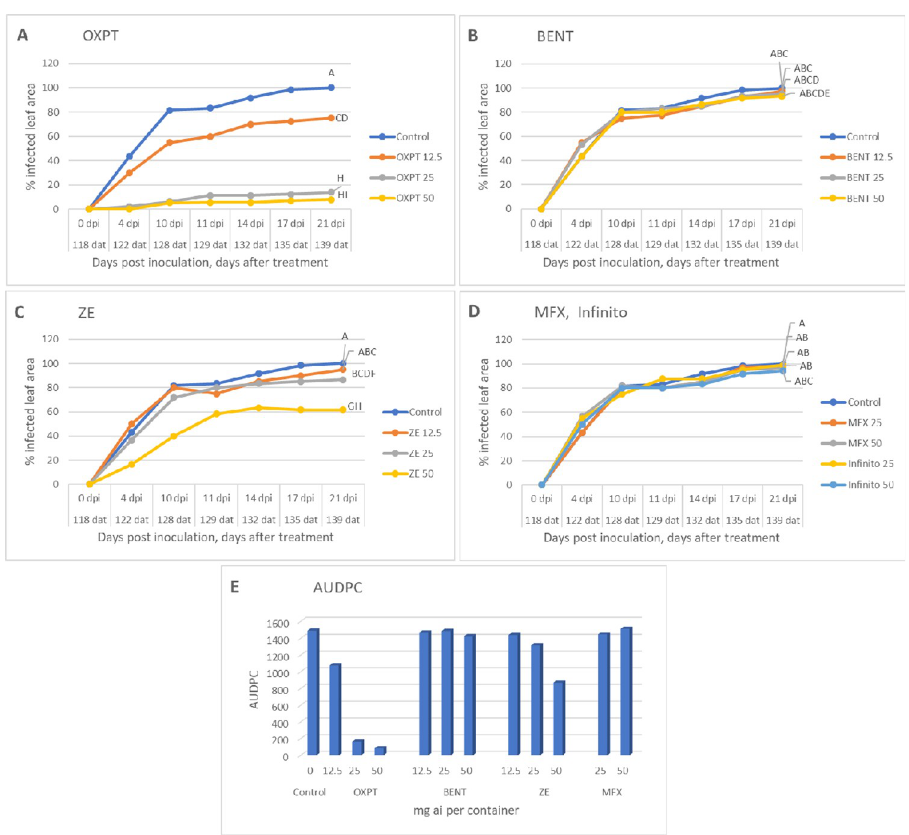
Fig 8. Persistence of fungicidal activity in soil. Soil in 64 L containers was drenched with each of five fungicides on 18.11.2019 and sown with potato Nicola on 7.1.2020, 118 days after treatment (dat). At about 10 weeks after sowing all plants were spray-inoculated with sporangial suspension of Phytophthora infestans . Disease progress was followed for 21 days after inoculation (139 dat) by recording the percent leaf area infected. A- oxathiapiprolin. B- Benthiavalicarb. C- Zorvec Endavia. D- Mefenoxam and Infinito. E- Area under disease progress curve. Different letters on the curves indicate on significant differences between treatments (n = 3) at 21 dpi (t-test, α =